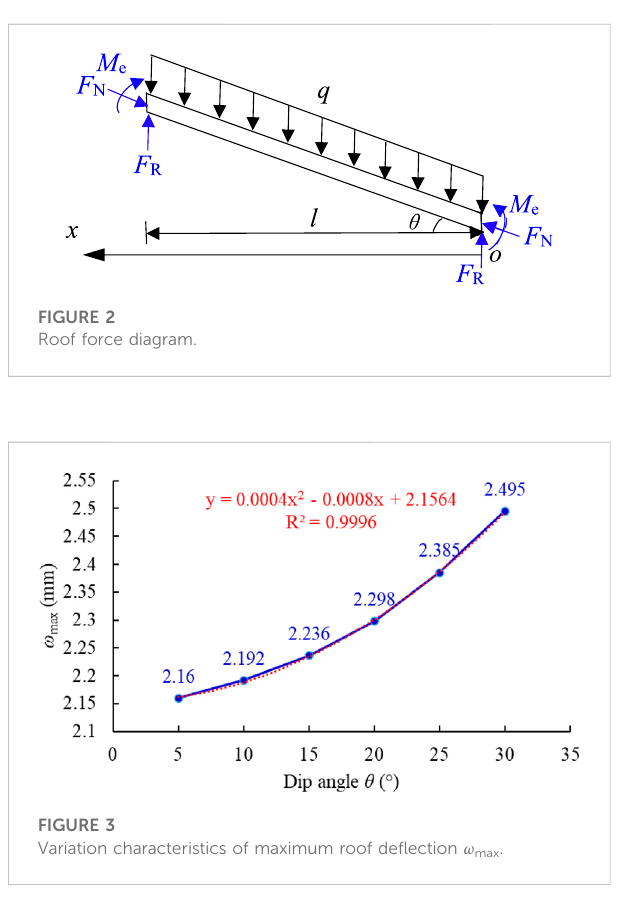
FIGURE 5 Force diagram of roadway high